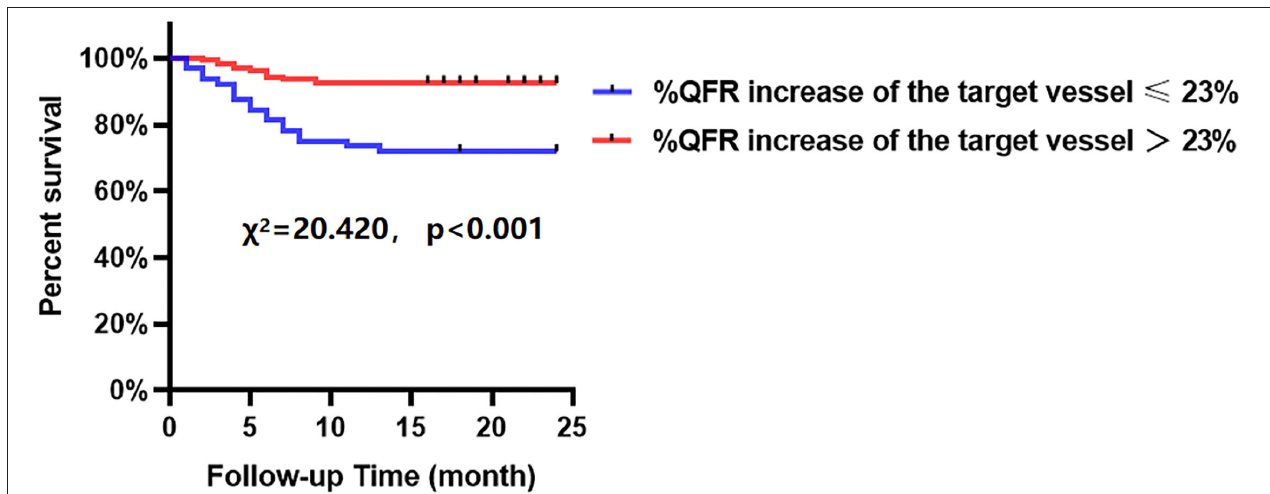
FIGURE 6 | Cumulative event-free survival probability of MACCEs in patients with NSTE-ACS who underwent PCI according to %QFR increase of the target vessel.